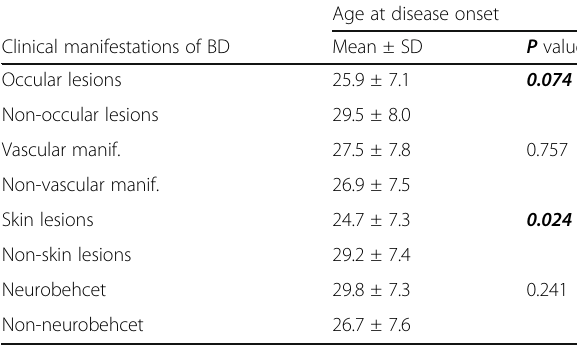
Table 8 Association of age at disease onset with different clinical manifestations of